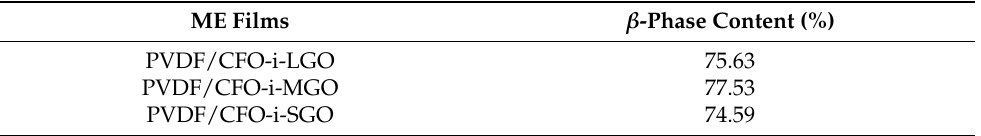
Table 3. Calculated β -phase content in the 3-2 type ME films of PVDF/CFO-i-LGO, PVDF/CFO-i- MGO, and PVDF/CFO-i-SGO.